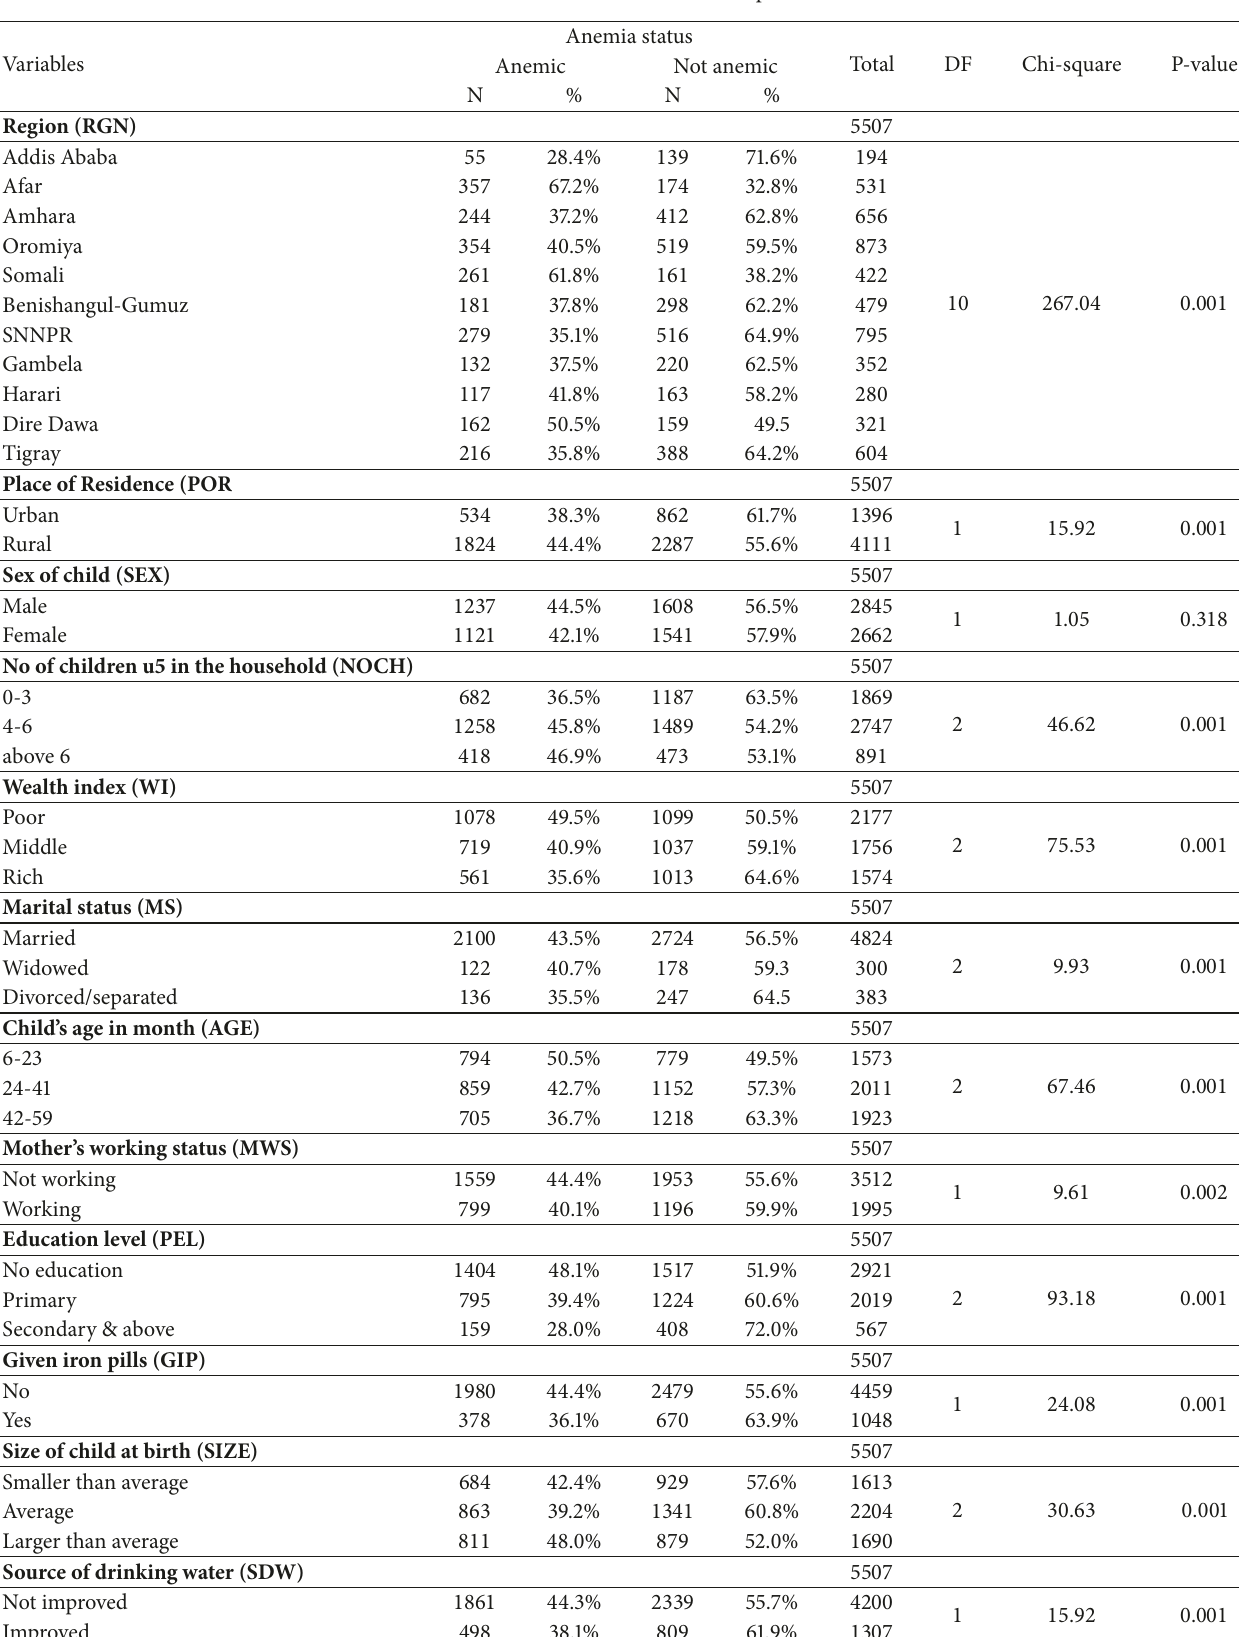
Table 1: Cross tabulation of anemia status versus predictor